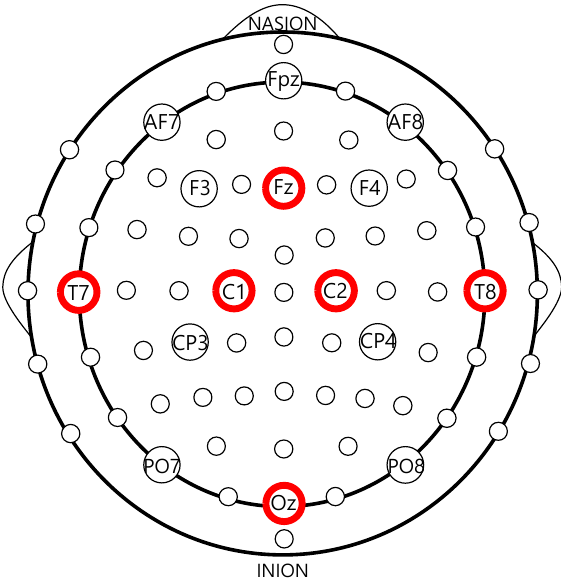
Figure 2. Six-channel measurement and collection locations of EEG vital-signals.